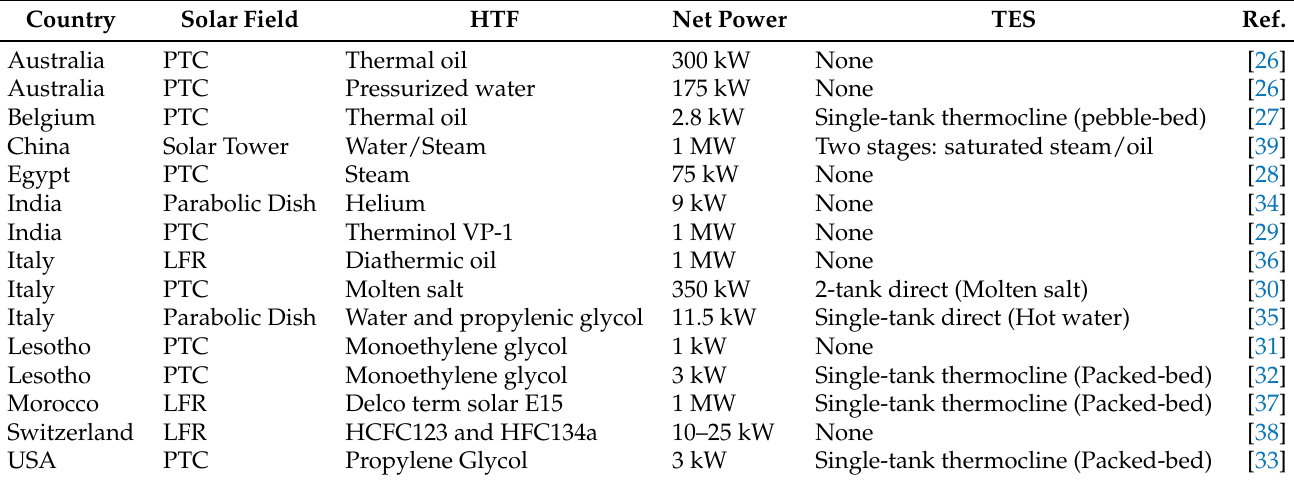
Table 2. Identified MicroCSP